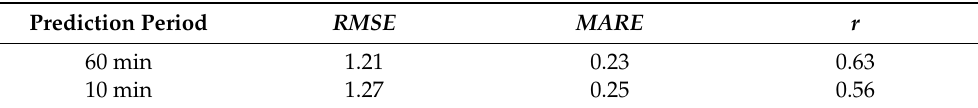
Table 5. Statistics for the evaluation of the performance of the models: root mean square error ( RMSE ), correlation coefficient ( r ), and mean absolute relative error ( MARE